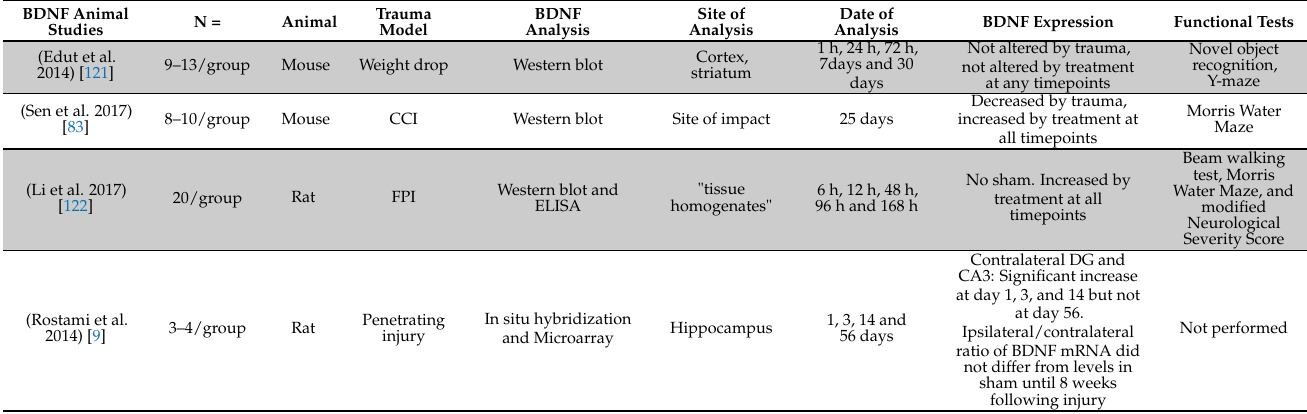
Table A2. Overview of the reviewed studies examining animals and a short summary of their reported